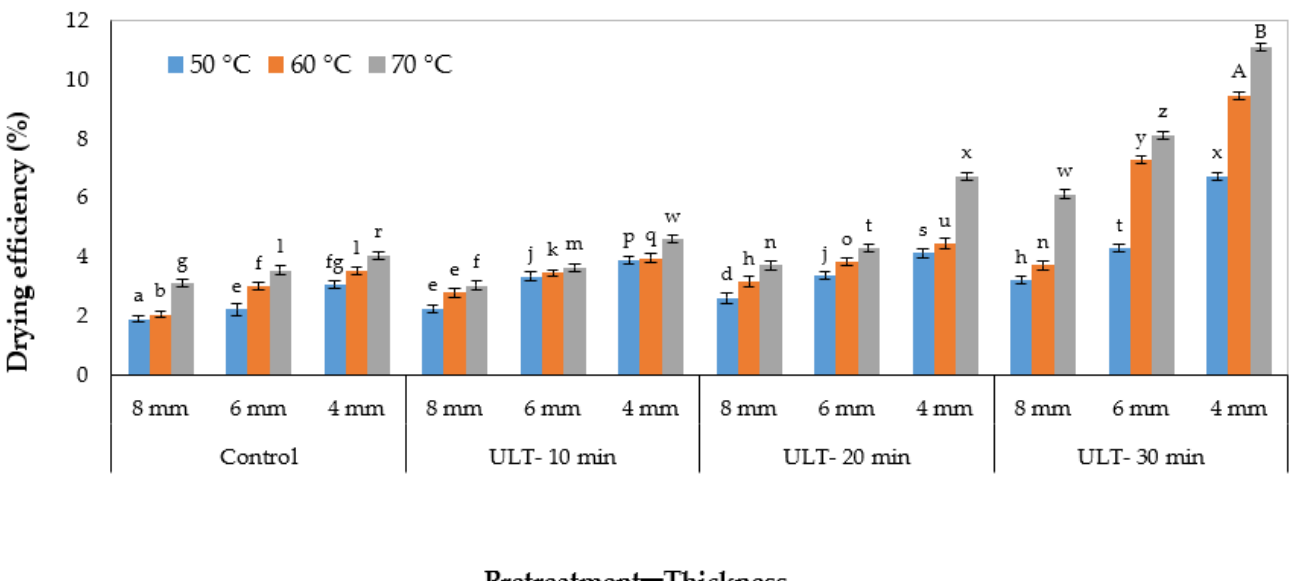
Figure 5. Drying efficiency under different conditions for drying kiwifruit slices.